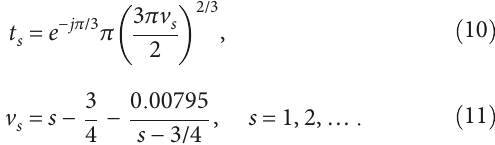
Figure 1: Comparison of the simulated amplitude of attenuation functions W Wait in the frequency domain calculated by our Newton – Raphson root- fi nding codes and that presented by Shao and Jacobson [5]. The solid lines are computed for a spherical earth with an assumed conductivity of 0.02S/m. The dashed lines are for a planar earth with the same conductivity, and only 200 and 500km path lengths are presented for the planar earth. Note that the attenuation function value presented here is twice as much as the calculated value by (3), because Shao and Jacobson [5] included the mirror e ff ect of perfectly conducting ground in the attenuation